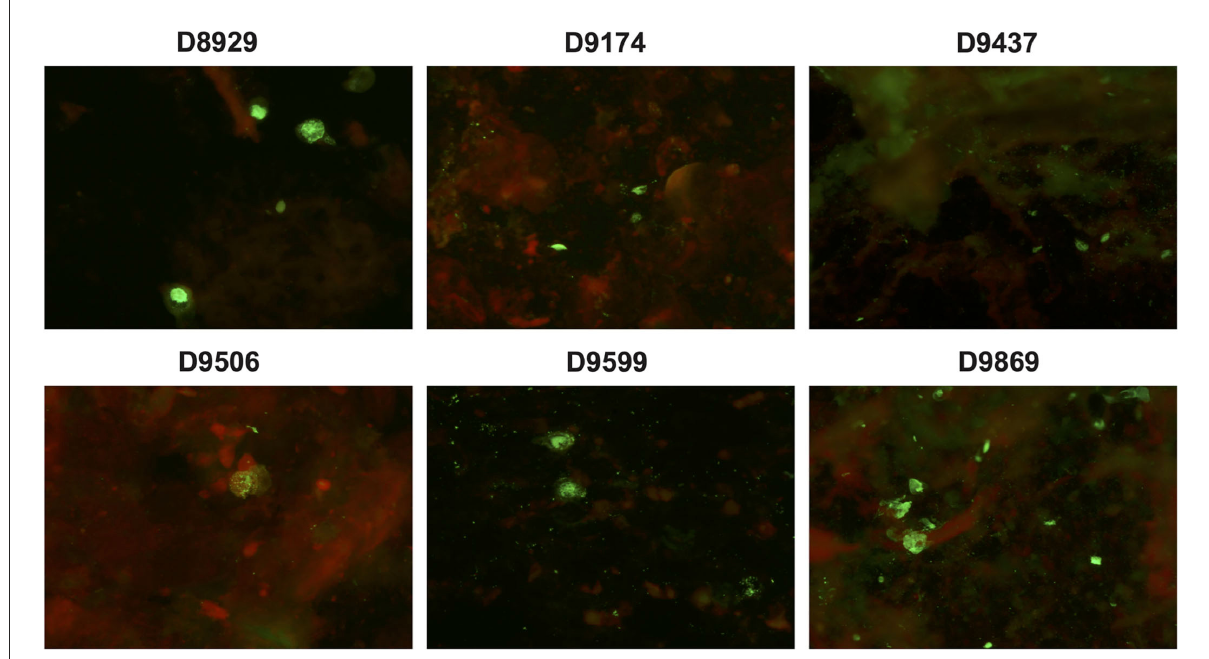
FIGURE2 Specific green fluorescent cells are shown in the antigen test of clinical specimens D8929, D9174, D9437, D9506, D9599, and D9869 reacting with anti-HBoV1 DR2 by indirect-immunofluorescence assay